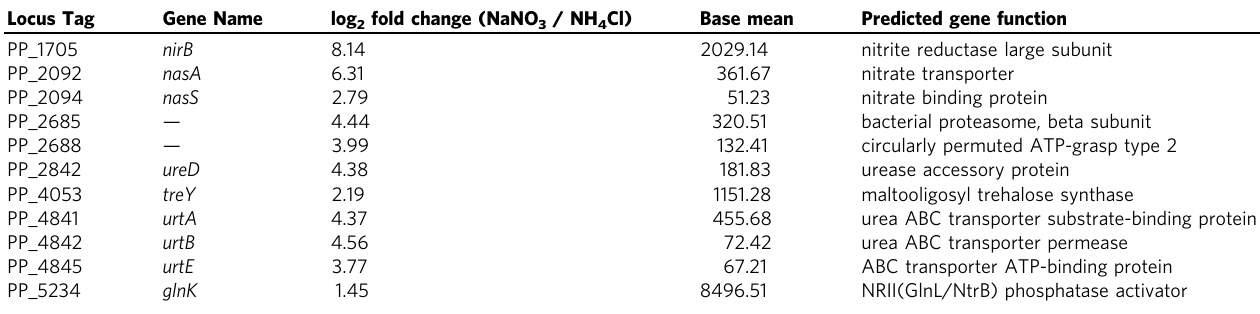
Table 2 Differential expression of genes downstream of potential nitrogen-sensitive promoters in P. putida JE1657. Locus Tag Gene